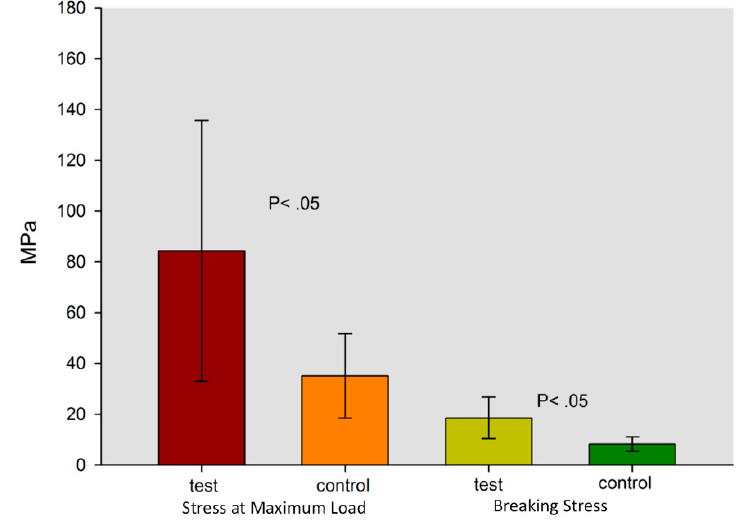
Figure 3. The graph shows the values of the two groups at Breaking Stress and at Maximum Load Stress.